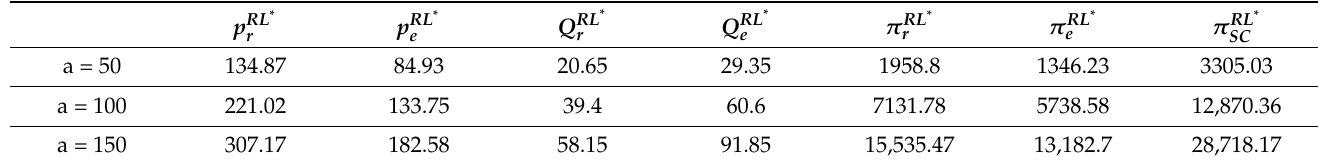
Table 8. Optimal decisions of channel members under the RL game—Case 3.